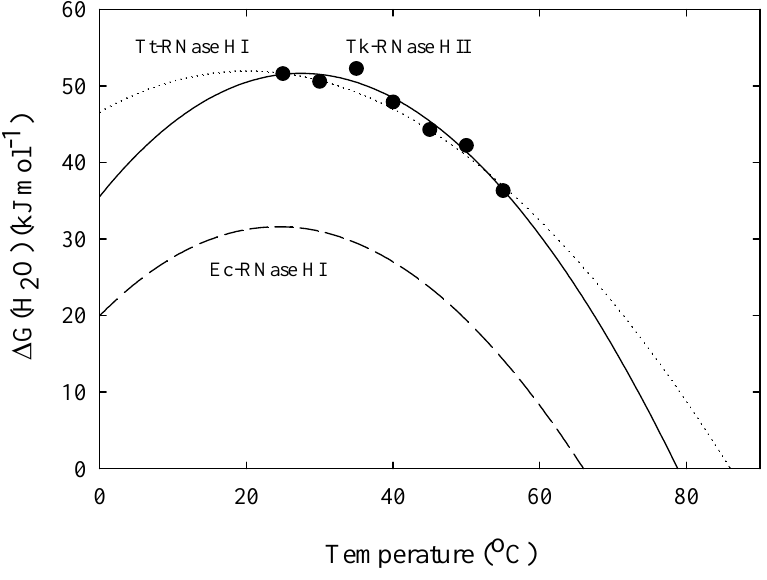
Figure 4. Thermodynamic stability profiles of Tk-RNase HII, Ec-RNase HI, and Tt-RNase HI, obtained from GdnHCl-induced equilibrium unfolding experiments [42]. The solid, dashed, and dotted lines represent Tk-RNase HII, Ec-RNase HI, and Tt-RNase HI. Figure is reproduced from